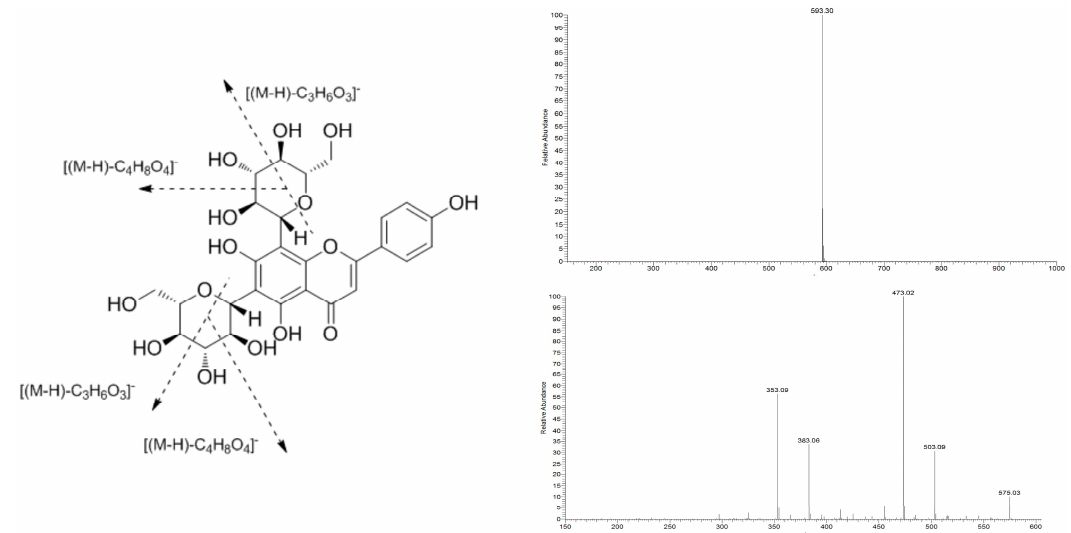
Figure 1. Structure and MS/MS spectra of Vicenin Ⅱ in negative ion mode.